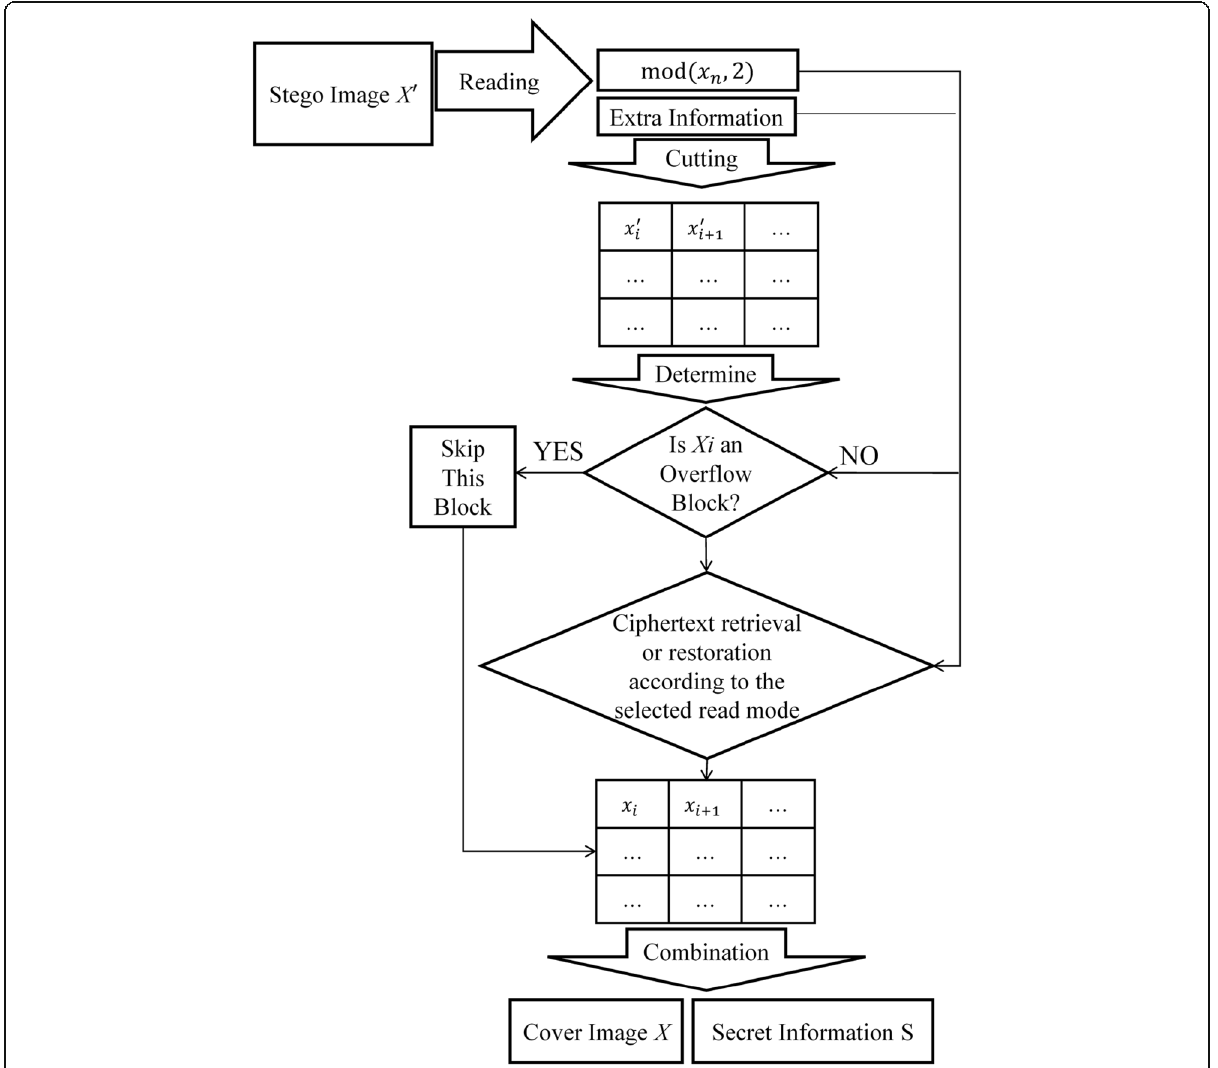
Fig. 6 Flowchart of ciphertext retrieval in the steganography method proposed in this study. The ciphertext retrieval steps of the steganography method proposed in this study are described in Fig.